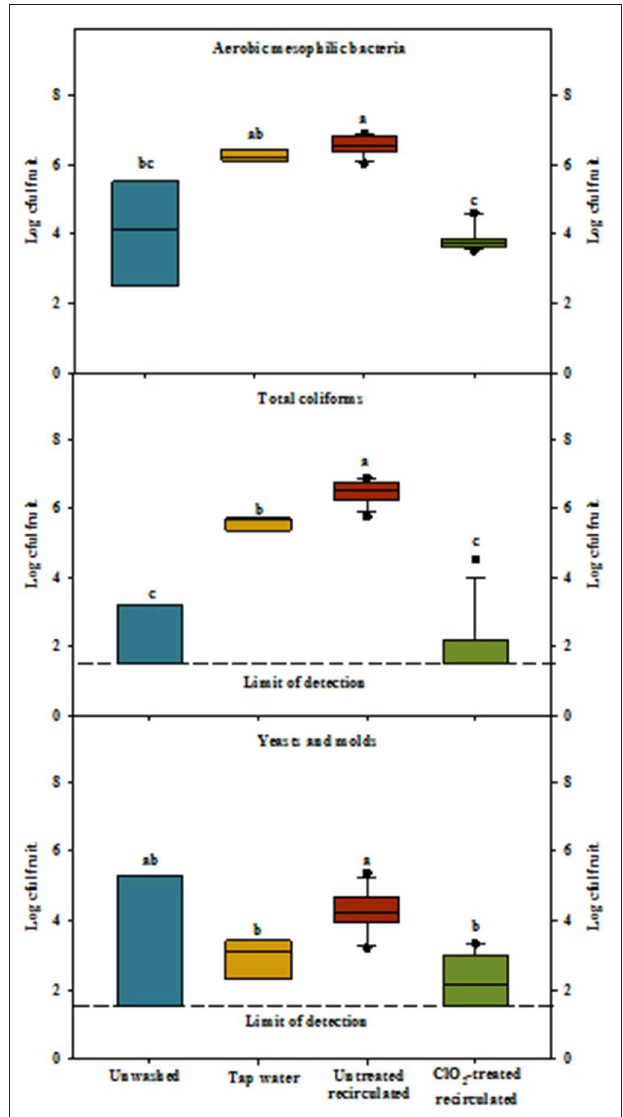
FIGURE 3 | Boxplots of different microbial groups (log cfu/fruit) in unwashed tomatoes, tomatoes washed with tap water (1st test), washed with untreated recirculated water (2nd test), and washed with ClO 2 -treated recirculated water (3rd test). Different letters above the boxplots indicate significant differences in the microbial population between different tomato